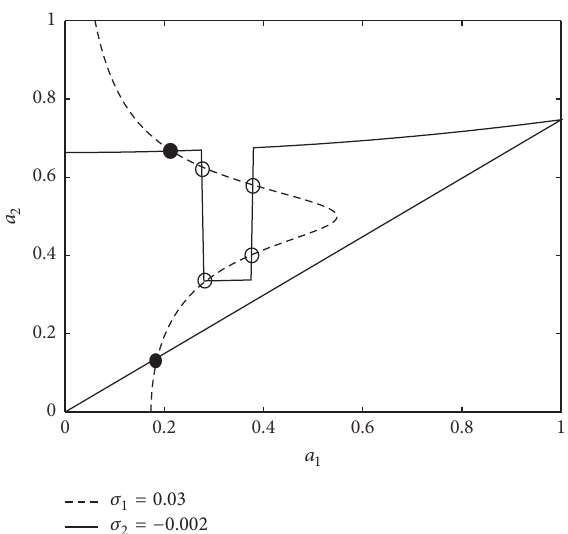
−0.002𝜎 1 = 0.03 𝜎 2 = Figure 6: Steady-state solution when 𝜎 1 = 0.03 [rad ⋅ s −1 ] and 𝜎 2 = −0.002 [rad ⋅ s −1